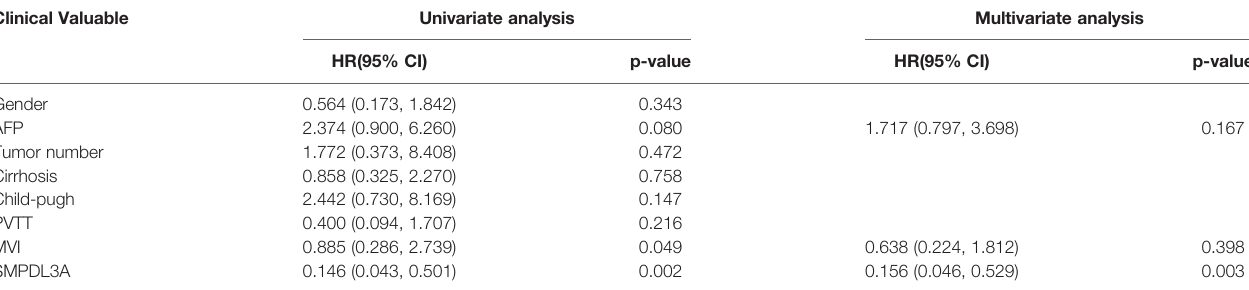
TABLE 5 | Univariate and multivariate analyses of independent risk factors for tumor-free survival of patients with hepatocellular carcinoma after hepatectomy. Clinical Valuable